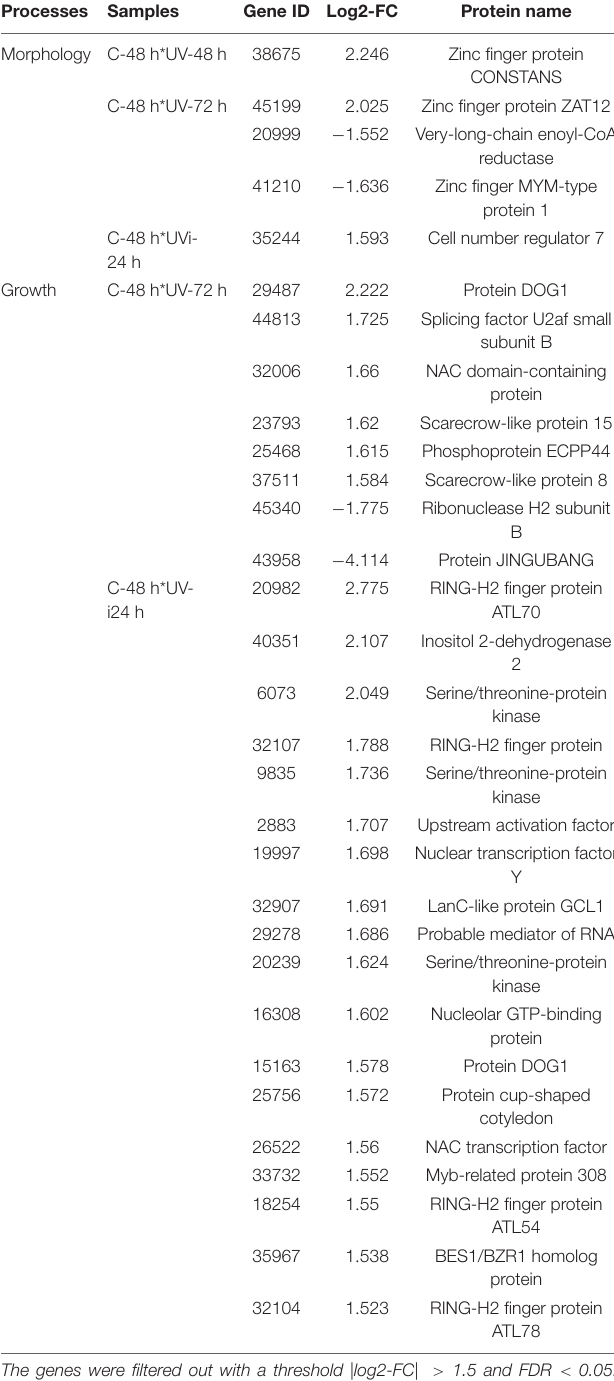
TABLE 3 | Relative expression of cell homeostasis and cell cycle arrest genes. Processes Samples